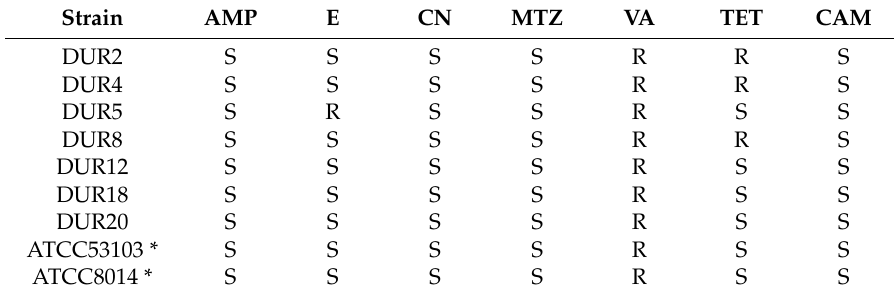
Table 5. Antibiotic susceptibility of seven isolated strains of Lactobacillus and the two reference strains. Strain